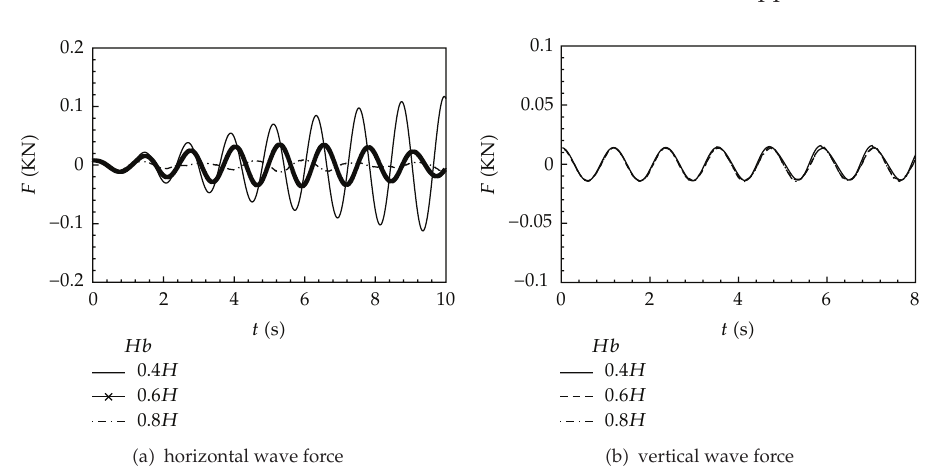
Figure 19: Time histories of total horizontal and vertical wave forces for D (cid:8) 0 . 0.